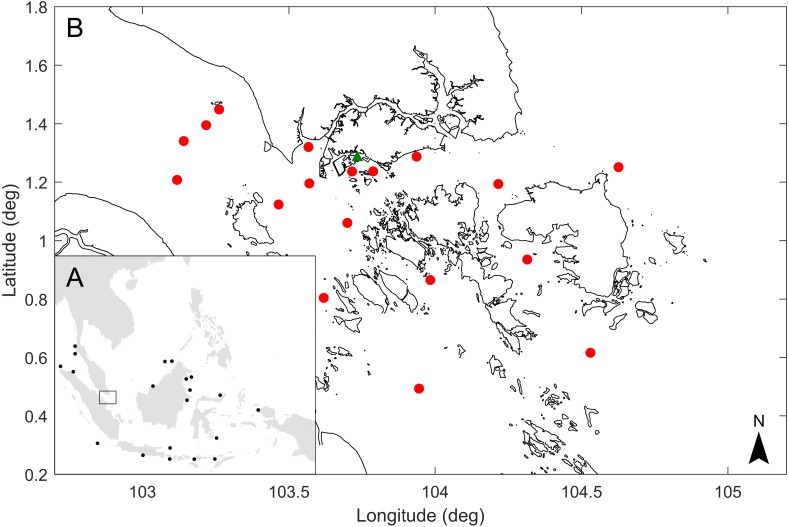
Map of sperm whale records in waters off Southeast Asia, location where the sperm whale was found in Singapore and approximate release points of simulated drogues representing the floating dead whale.(A) Black dots represent sperm whale records in Southeast Asia (Anderson & Kinze, 1999; Barnes, 2005; De Boer, 2000; Anon, 2017; Anon, 2018; Cahya & Simanjuntak, 2017; Mustika et al., 2009; Mueanhawong, 2012; Ponnampalam, 2012). (B) Green triangle shows the location where the sperm whale carcass was found in Singapore, and red dots show the approximate release points in the vicinity of Singapore of simulated drogues.